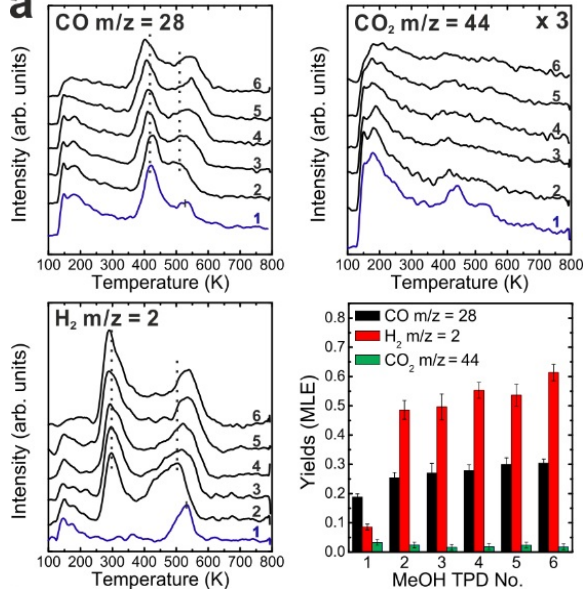
Figure 8. Cont. Figure 8.